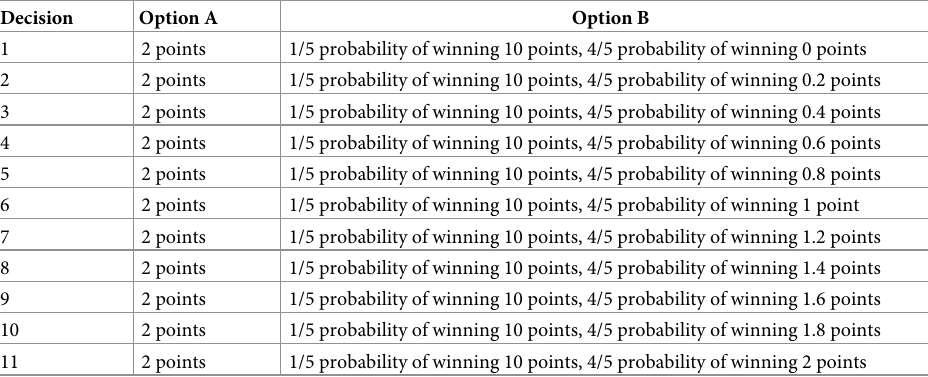
Table 3. Lotteries in grade points treatment, Po .